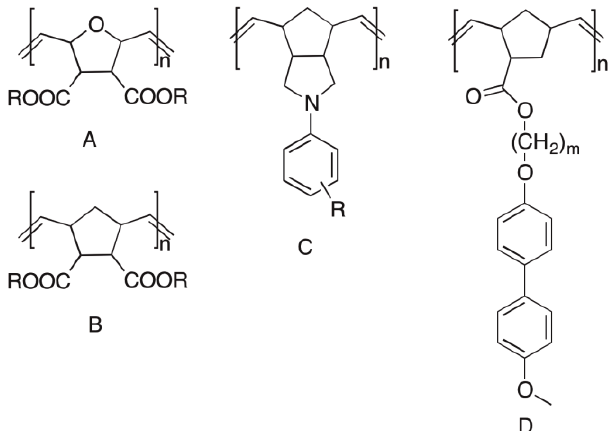
Figure 53. Functional polymers via ROMP: ( A ) Super absorber, after crosslinking [141]; ( B ) Ion exchange resin, flocculation aid [141]; ( C ) High temperature thermoplast [141];